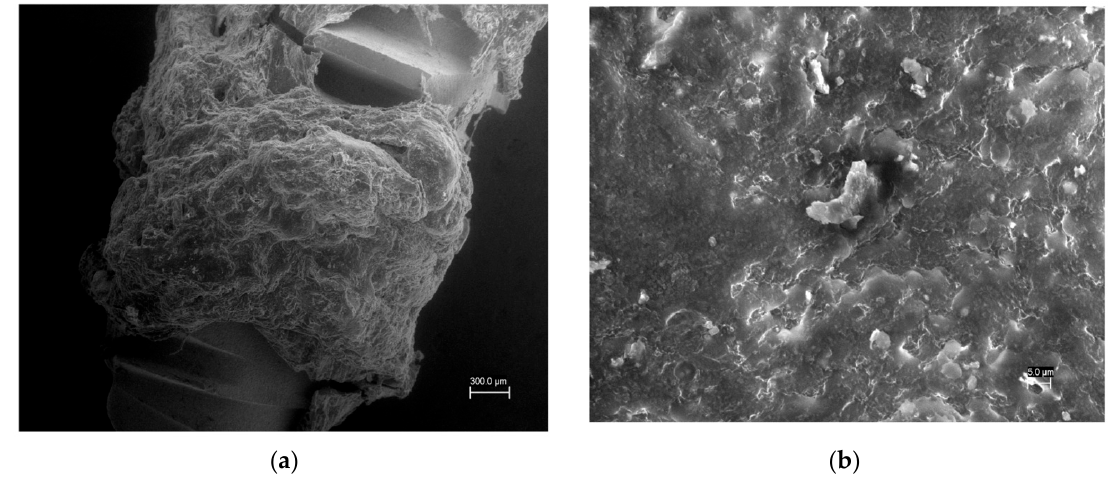
Figure 4. ( a ) SEM photomicrograph of the CGF-permeated implant. ( b ) Large magnified image of the CGF-permeated implant detail.